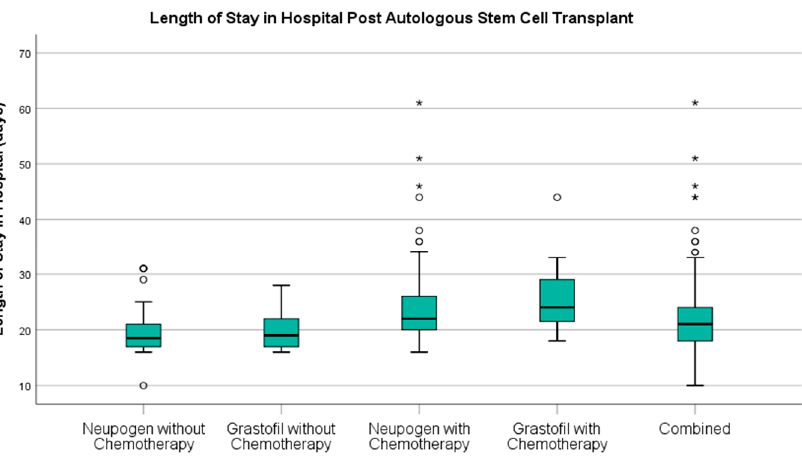
Figure 3. Length of stay in hospital for patients post autologous stem cell transplant. * denotes extreme outlier